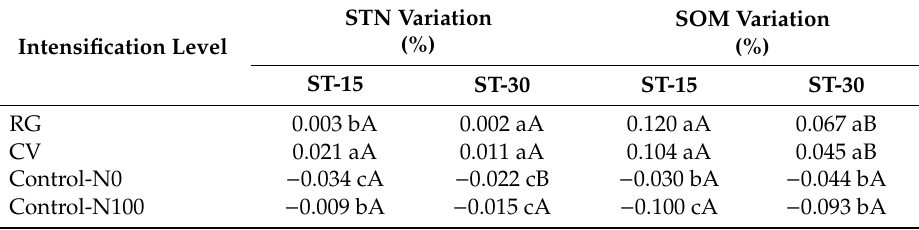
Table 3. Soil organic matter and total nitrogen variations occurred after cover crop green manuring at pepper harvesting. The interaction between the two main factors are reported (intensification level × soil tillage). Values belonging to the characteristic and treatment with di ff erent letters are statistically di ff erent, according to LSD (0.05) in rows for soil tillage (upper-case letter) and in columns for the intensification level (lower-case